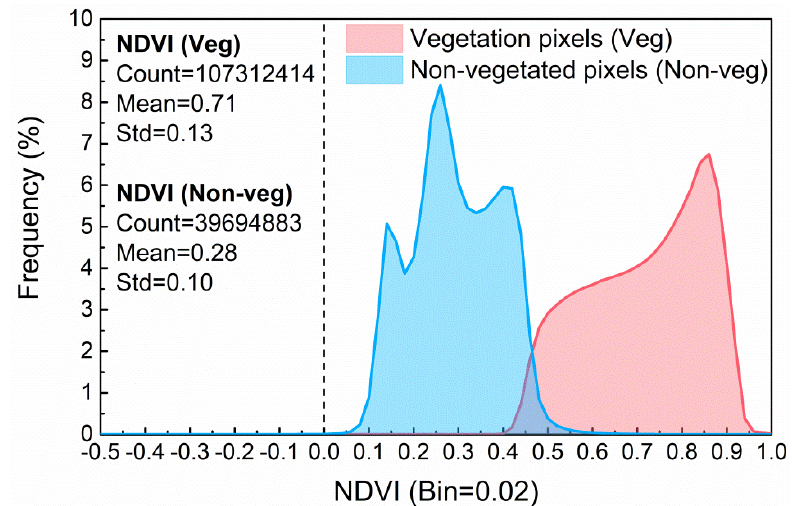
Figure 4. The histogram of NDVI for vegetation (red area) and non-vegetated (blue area) pixels, respectively. The statistical results (pixel count, mean and standard deviation (std) value of pixels) for all vegetation (red area) and non-vegetated (blue area) pixels are shown in the left panel.